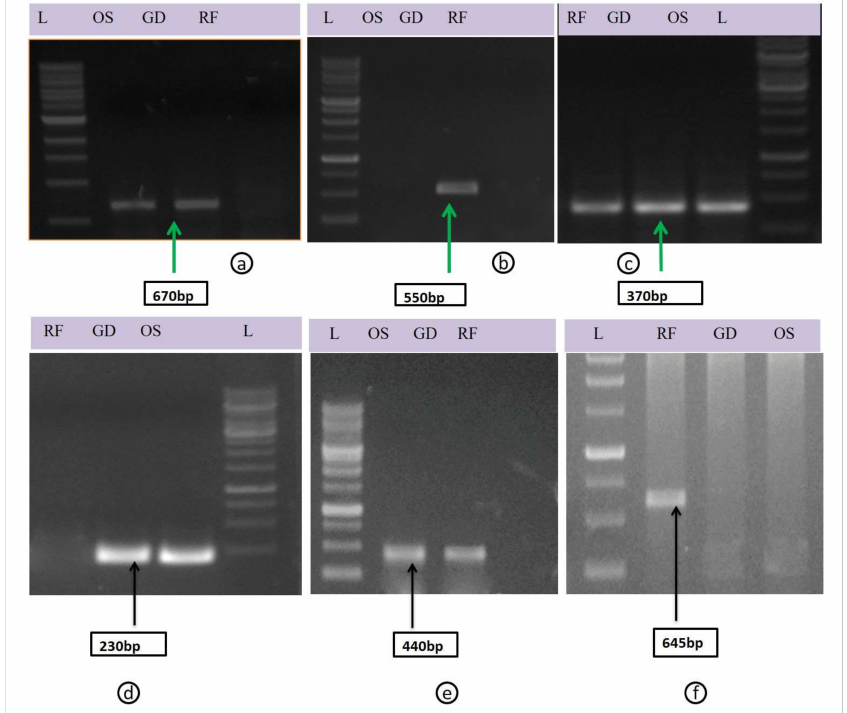
Figure 3. The PCR products from amplified region of viruses ( a ) ApNMV, ( b ) ApMV, ( c ) ASPV, ( d ) ASGV, ( e ) AHVd, ( f ) ACLSV L-1kb Ladder, OS: Oregon spur, GD: Golden Delicious, RF: Red